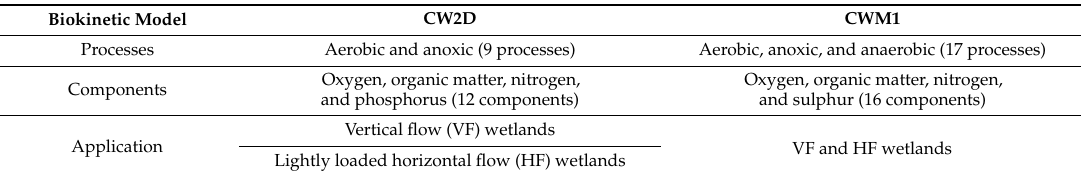
Table 1. Processes and components (a number of components/processes in brackets) and applications of the biokinetic models CW2D (Constructed Wetland 2D) and CWM1 (Constructed Wetland Model #1) [7].